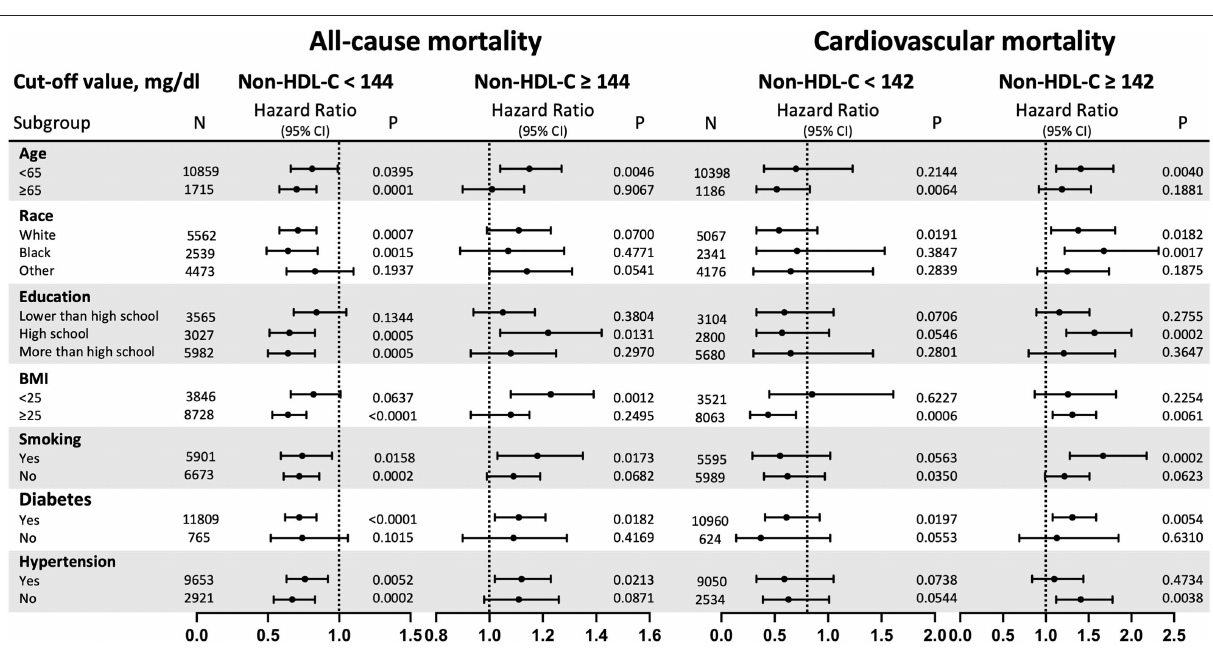
FIGURE 4 | Subgroup analysis. Non-HDL-C, non-high-density lipoprotein cholesterol; HR, hazard ratio; CI, confidence interval; BMI, body mass index. Results are expressed as multivariable-adjusted HR in continuous analyses (Non-HDL-C per 30 mg/dl increment). When analysing a subgroup variable, age, race, education, BMI, systolic blood pressure, diastolic blood pressure, smoking, diabetes, hypertension, coronary heart disease, stroke, creatinine, haemoglobin, glycated haemoglobin A1c, triglycerides, energy intake, protein intake, carbohydrate intake, and total fat intake were all adjusted except the variable